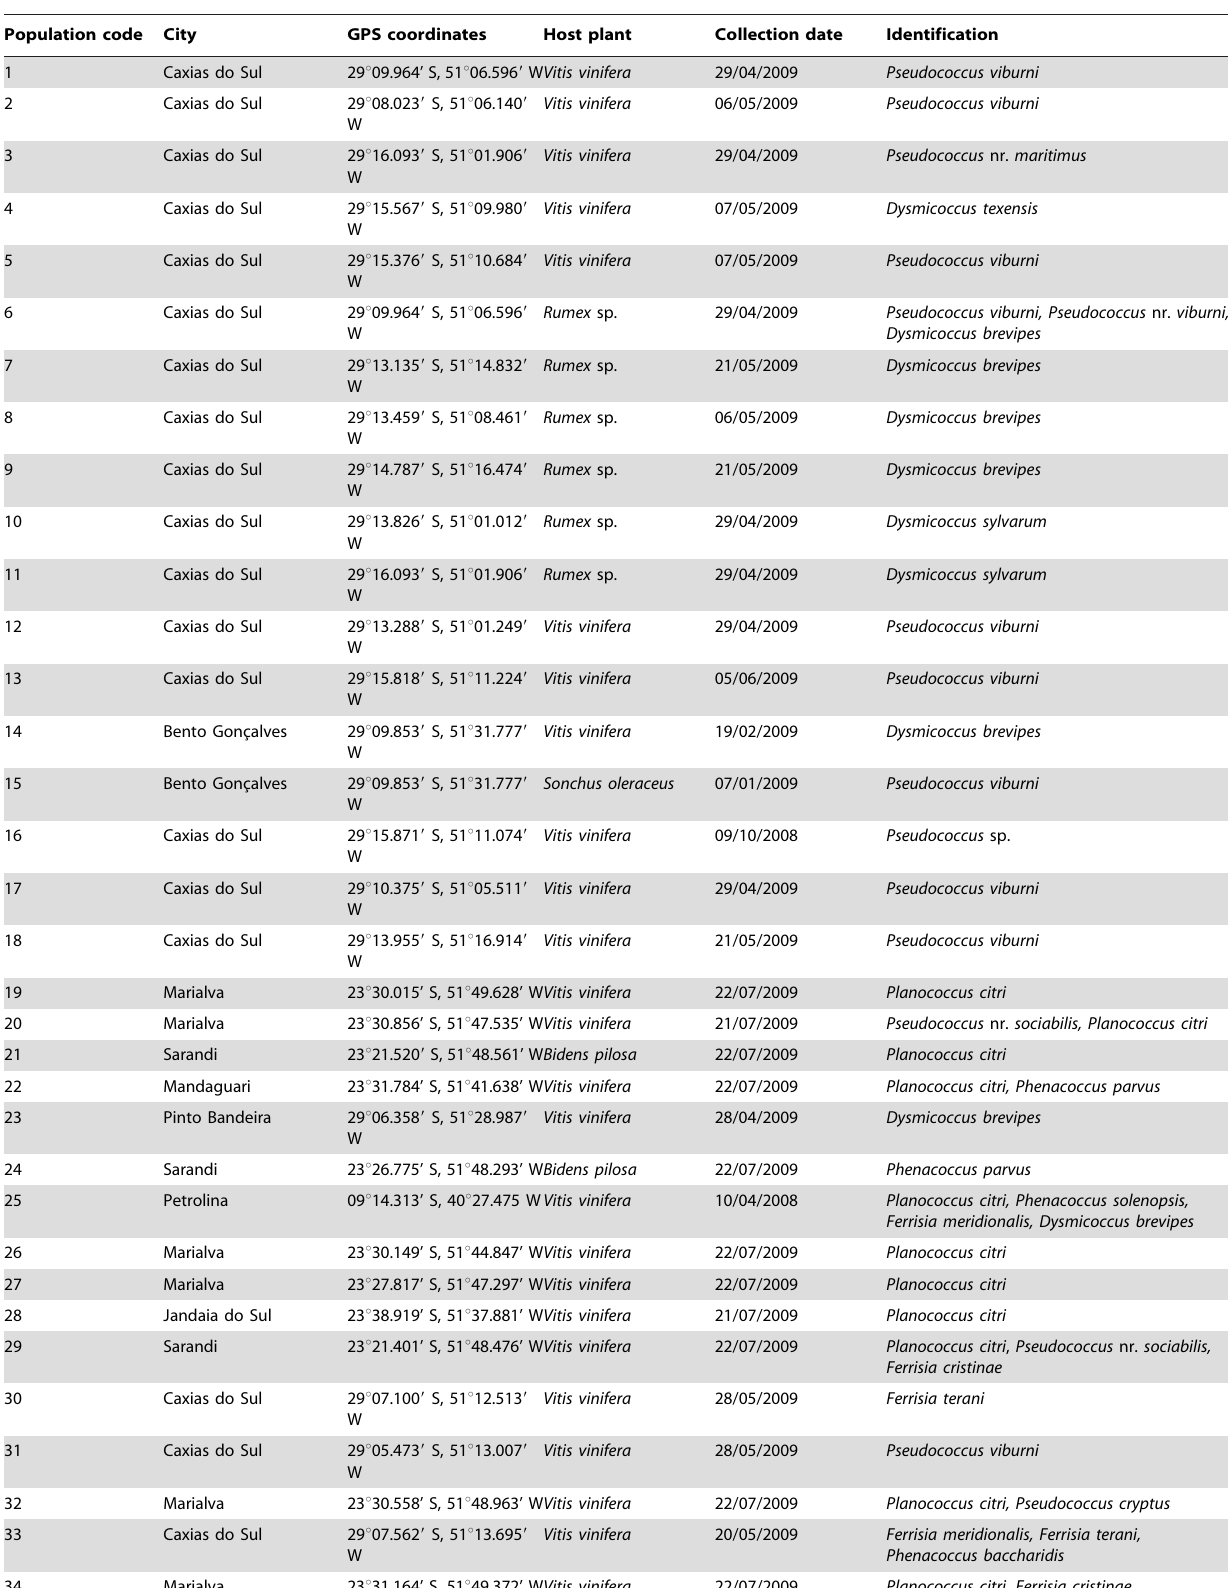
Table 1. List of populations sampled: Population code, geographic origin and host origin of the samples.